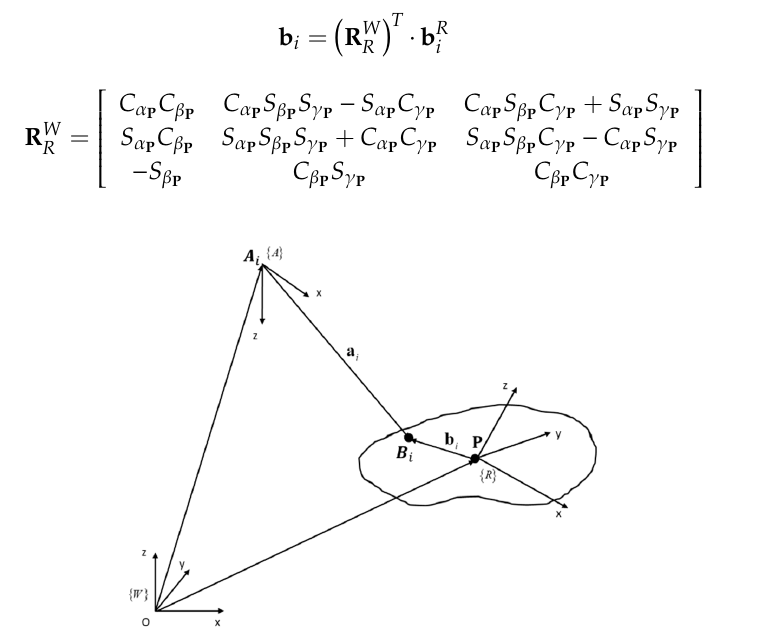
Figure 2. General geometric model of cable-driven parallel manipulators (CDPM).